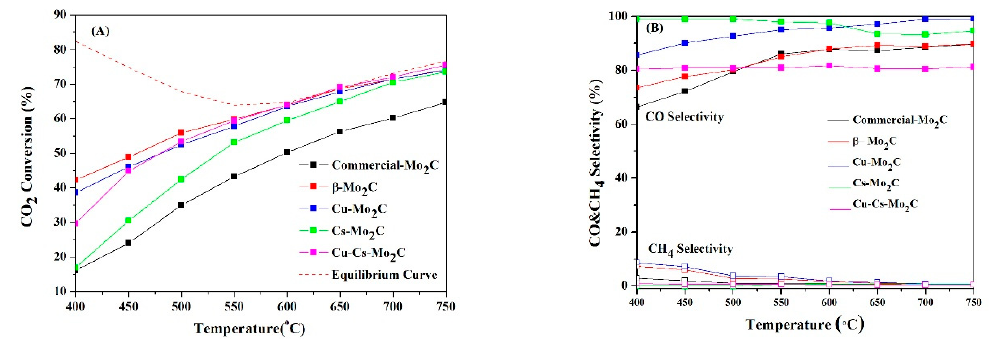
Figure 3. ( A ) CO 2 conversion ( B ) CO and CH 4 selectivity for the β -Mo 2 C, Cu-Mo 2 C, Cs-Mo 2 C, Cu-Cs-Mo 2 C and commercial Mo 2 C.